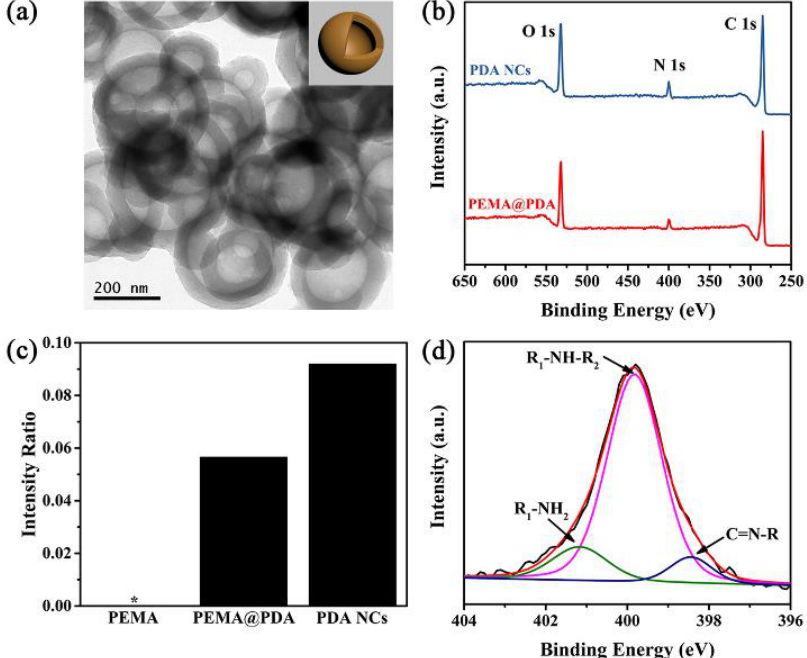
Figure 3. ( a ) TEM image of PDA NCs (inset: a schematic illustration of PDA NCs); ( b ) wide-scan XPS spectra; ( c ) N/C intensity ratio of specimens, and ( d ) N 1s XPS fitting spectrum of PDA NCs.